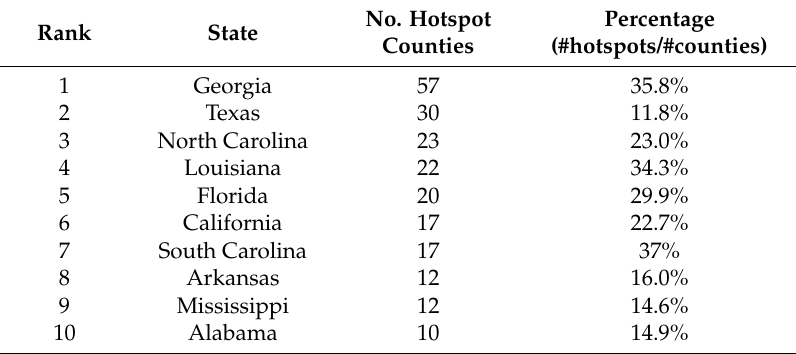
Figure 4. Hotspot map for the STIR in the continental US identified by hotspot analysis (Getis–Ord Gi*) technique, 2006–2010. Table 1. Top 10 states with the largest number of hotspot counties ( p < 0.10) of smoothed tuberculosis (TB) incidence rate (STIR) in the continental US,